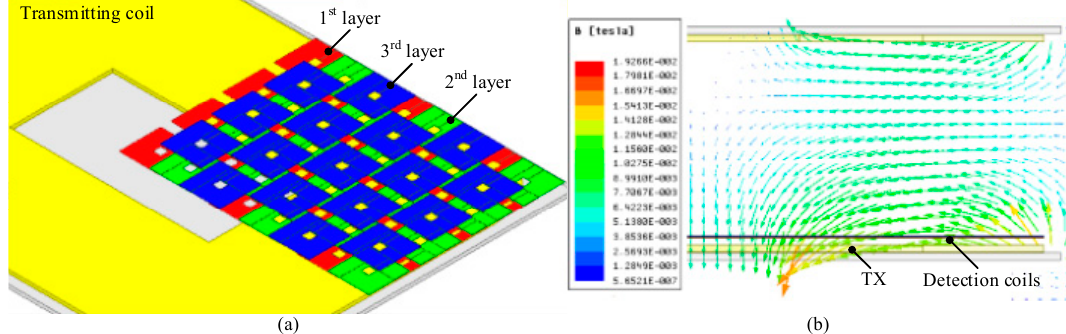
Figure 3. ( a ) Model of a quarter of the three-layer hexagonal layout detection coils in Maxwell. ( b ) Half of the magnetic field distribution between the transmitter and receiver.